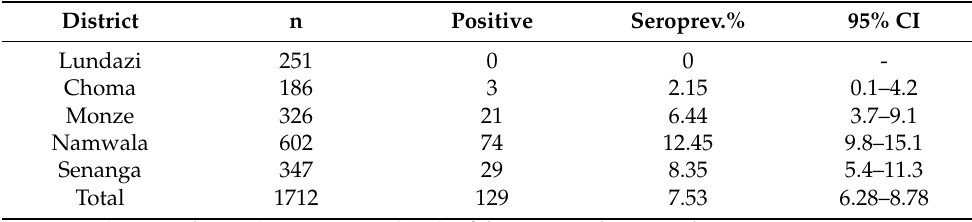
Table 1. Individual animal brucellosis seroprevalence by district.